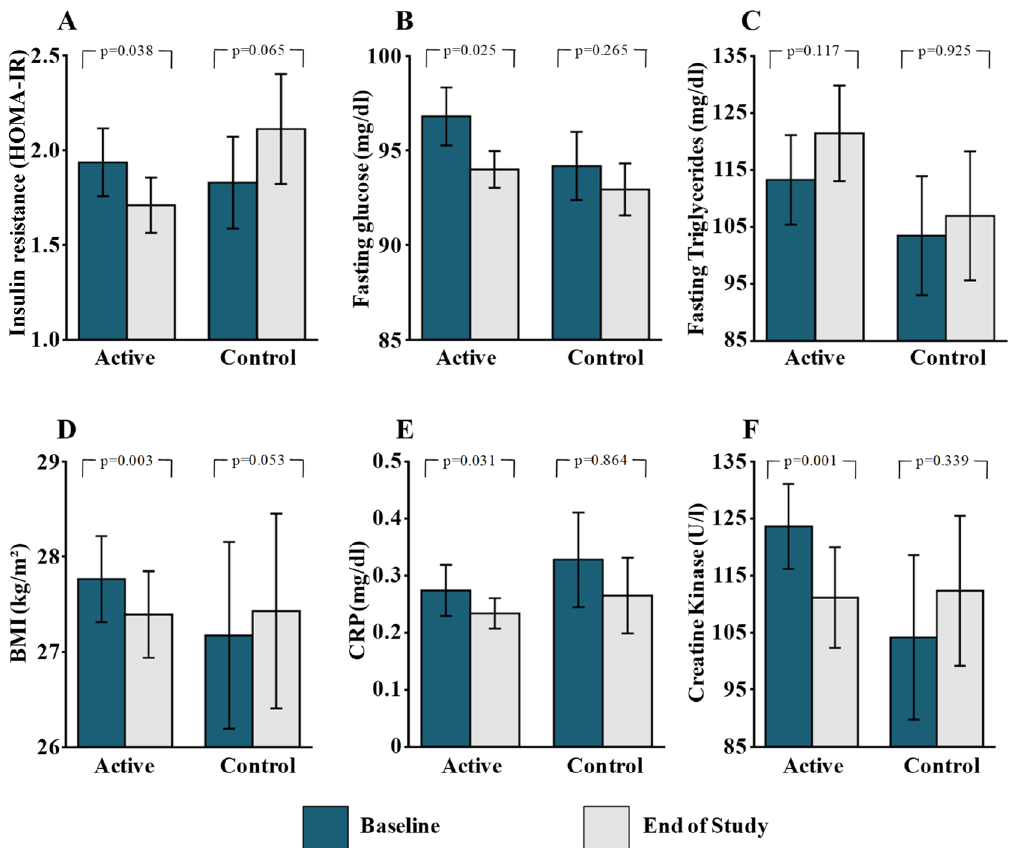
Figure 2. BMI Body mass index, CRP C-reactive protein, CK creatinine kinase. Mean changes in insulin resistance ( A ), fasting glucose ( B ), fasting triglycerides ( C ), BMI ( D ), CRP ( E ) and CK ( F ) with eccentric endurance exercise and in the control group. BMI denotes body mass index, insulin sensitivity is measured by the HOMA index calculated by the formula insulin (mU l –1 ) × fasting plasma glucose (mmol l –1 )]/22.5. CK denotes creatine